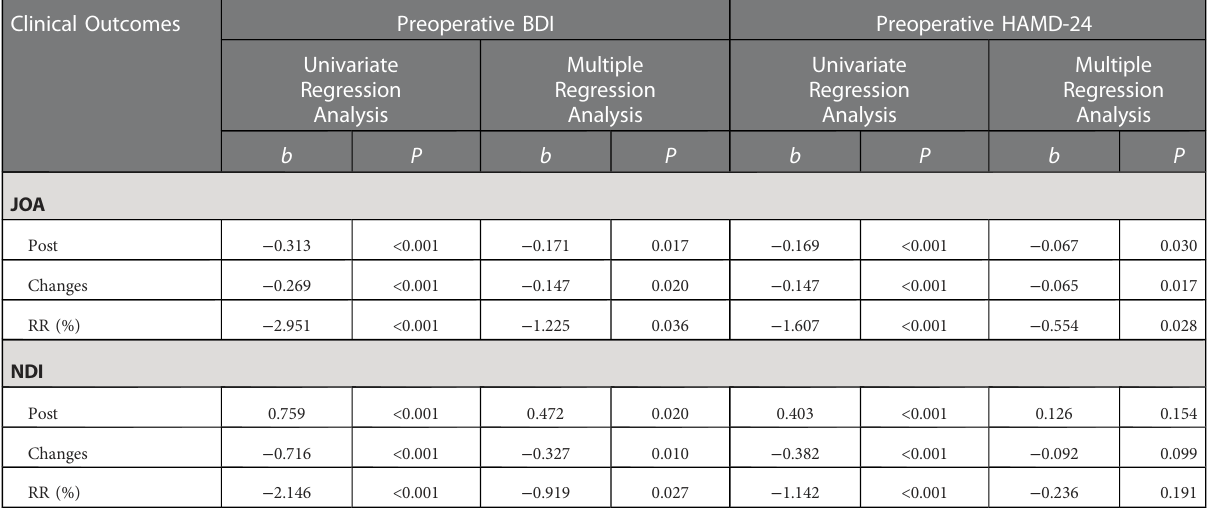
TABLE 3 Correlation between preoperative BDI, HAMD-24 and postoperative clinical outcomes and improvement by using regression analysis. Clinical